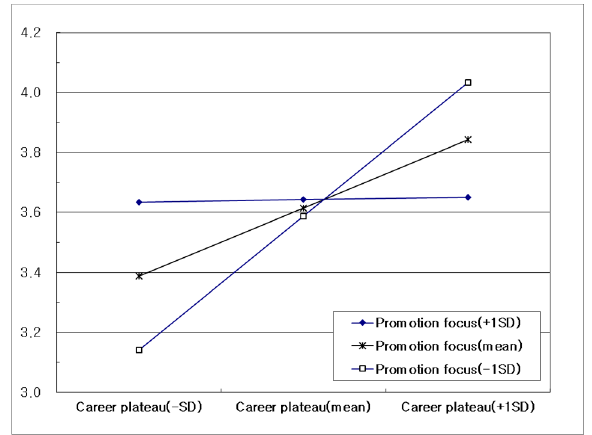
Figure 2. Moderating effect of promotion focus on job burnout.